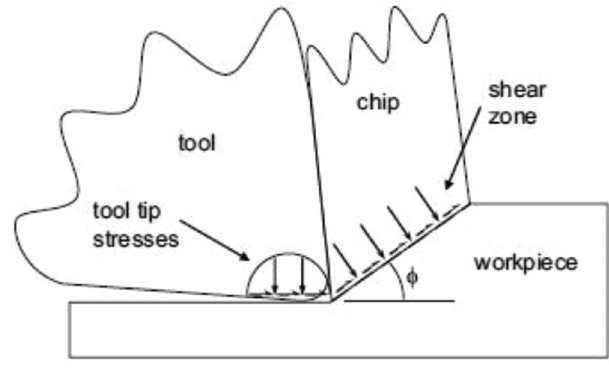
Fig. 5. Schematic of mechanical stresses sources [15].